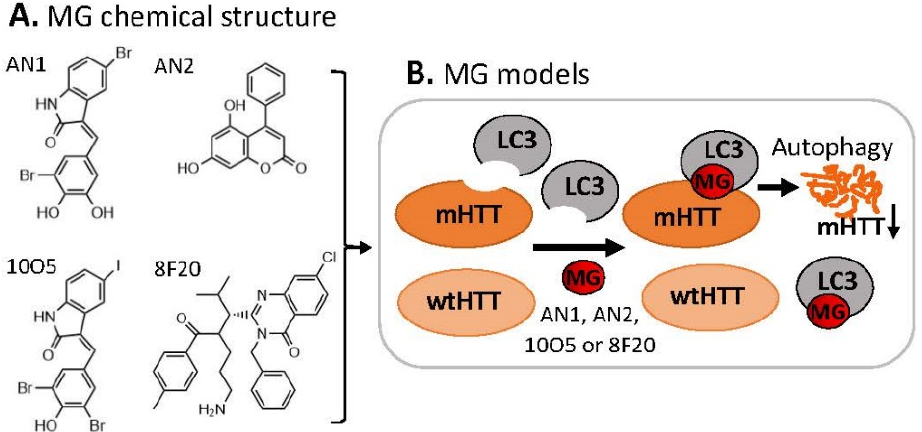
Figure 12. ( A ) Chemical structure of AN1, AN2, 10O5, and 8F20 as MG compounds; ( B ) a cartoon model to show the key finding for disease treatment. Such types of MG discovered by the logically designed assay could only ligate LC3 to mHTT but not wtHTT. Thus, mHTT could be glued on LC3 for degradation of mHTT but not wtHTT by autophagy.